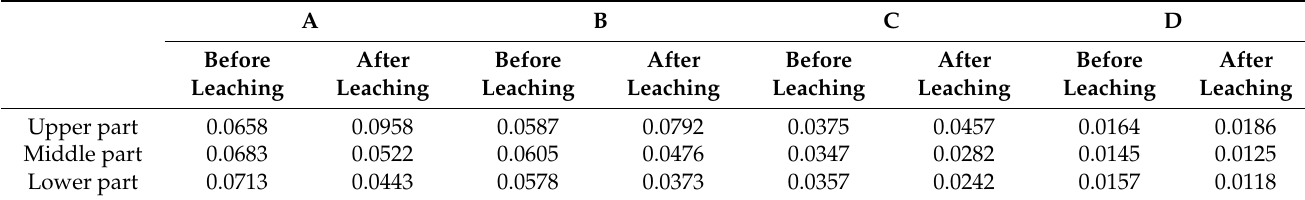
Table 1. Pore connectivity of four kinds of ore